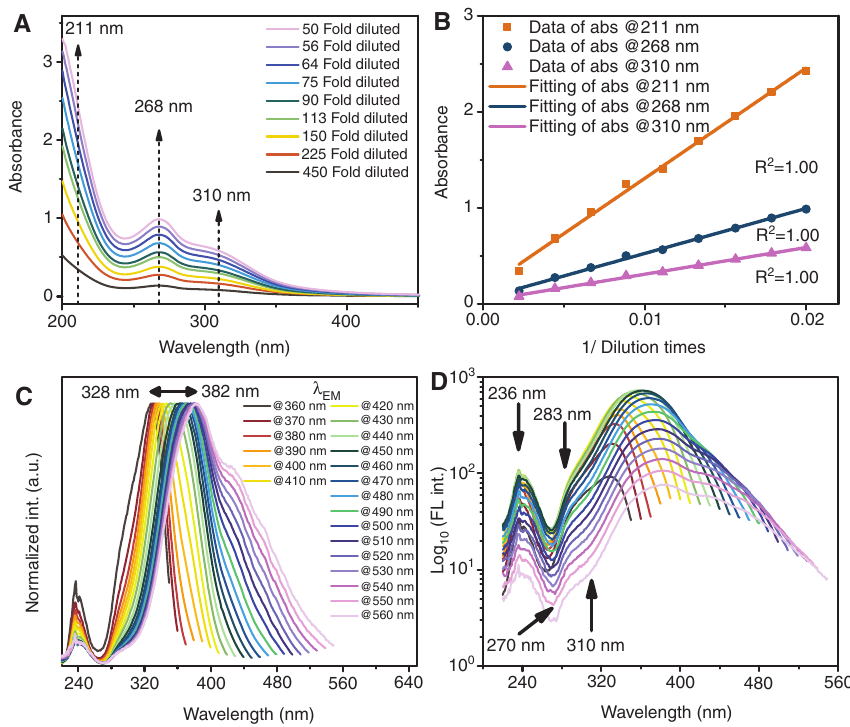
Figure 5: (A) UV-vis absorption spectra of NGQDs with different dilution folds. (B) Linear dependence of the absorbance at 211, 268, and 310 nm on 1/dilution times. (C) Normalized FLE spectra of NGQDs measured by monitoring the λ (FL intensity) versus wavelength of NGQDs. Both (C) and (D) are derived from Figure